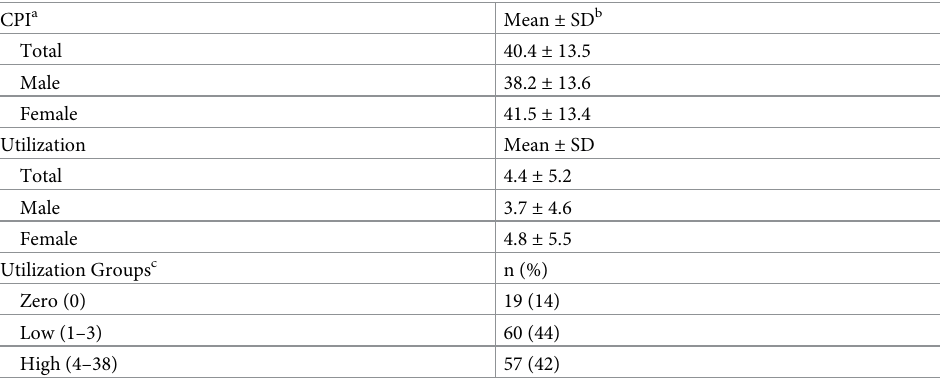
Table 2. Phenotype summary, n =